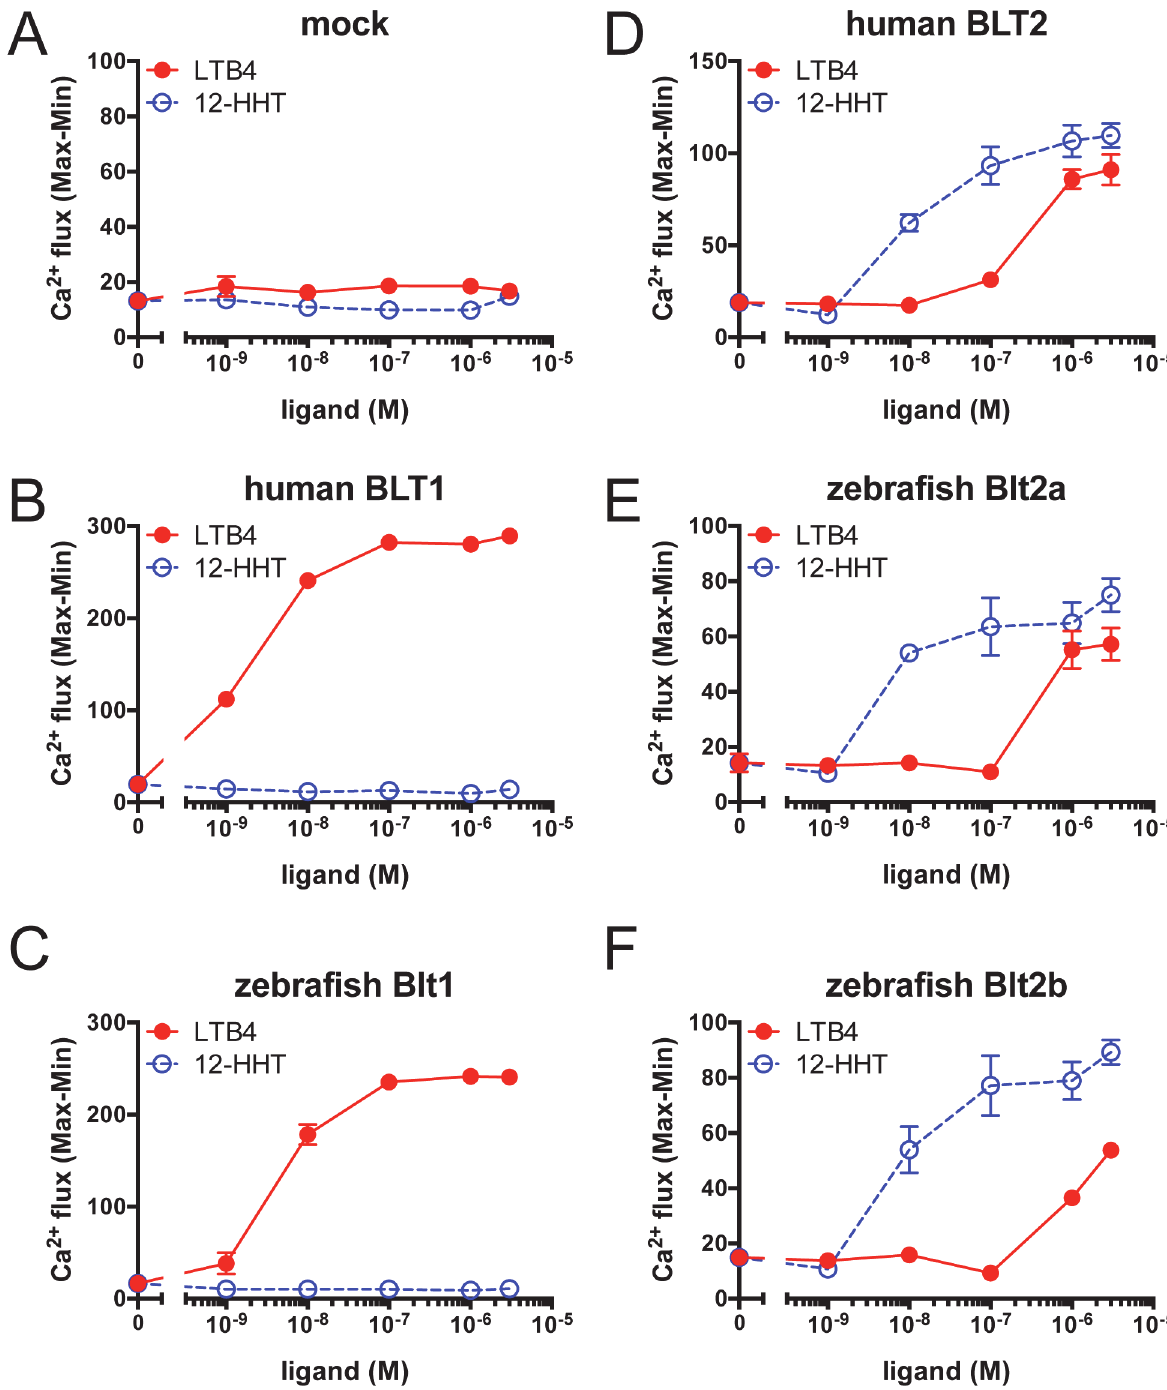
Fig 5. Calcium mobilization in CHO cells expressing the zebrafish Blt receptors. Intracellular calcium mobilization in CHO cells stably expressing hBLT1, zebrafish Blt1, hBLT2, zebrafish Blt2a, or Blt2b was analyzed using a FlexStation plate reader to measure fluorescence intensity. Data represent the mean ± s.e.m. (n = 4). These data are representative of atleast two independent experiments with similar